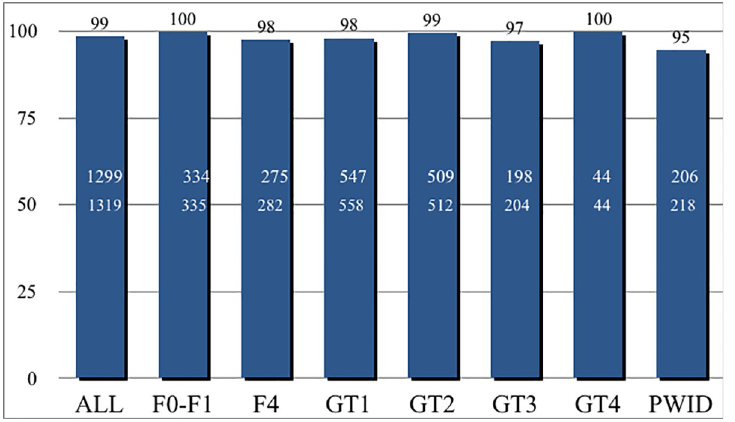
Fig 2. Proportion of patients with concomitant therapies. The figure shows the proportion of patients taking one ore more concomitant medications in this real world cohort. Only 191 patients (14.4%) were not taking concomitant medications. Up to 70% were taking 4 to 8 pill per day in addition to the antiviral treatment